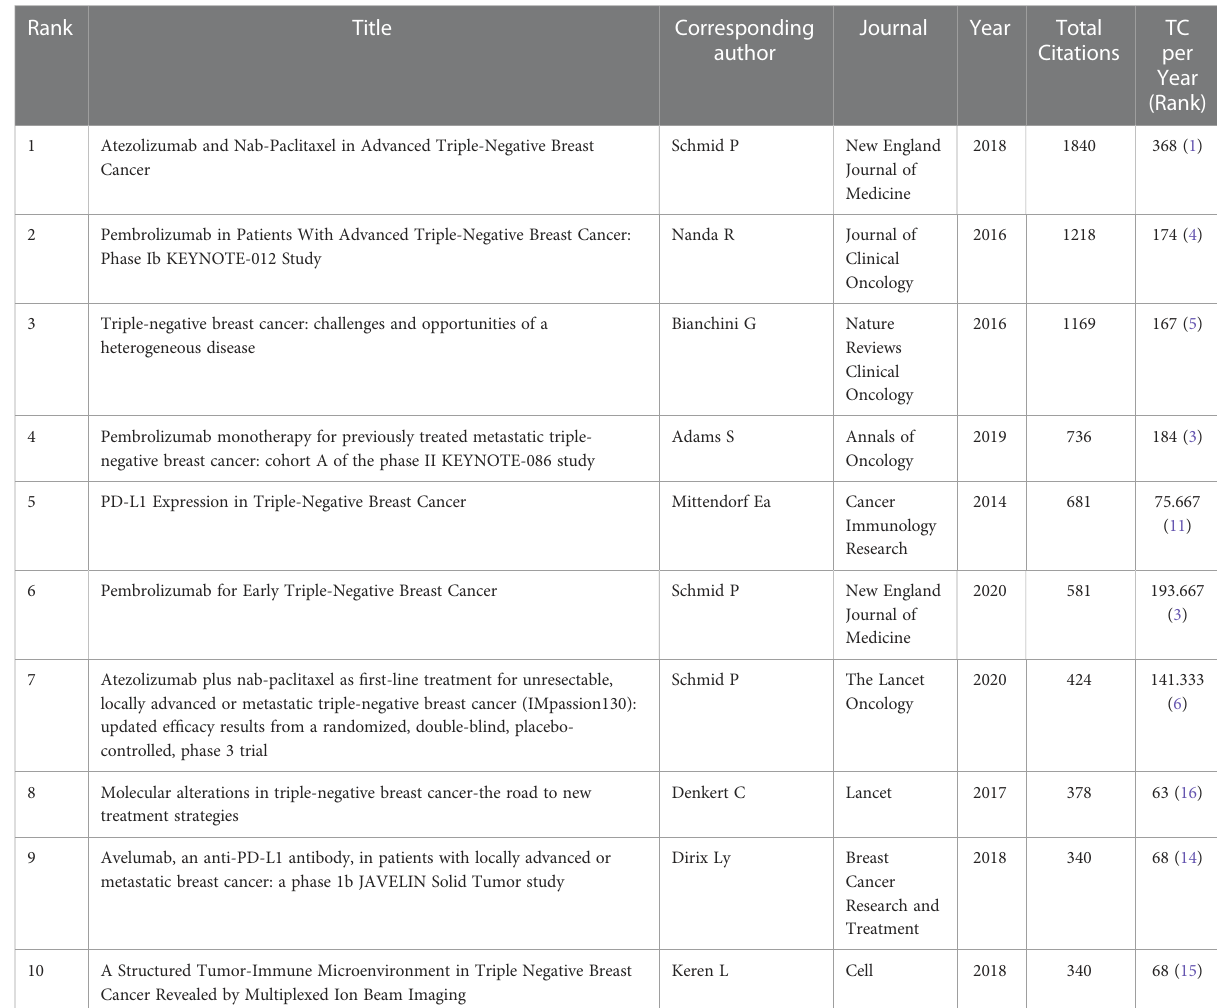
TABLE 3 The details of the top 10 cited